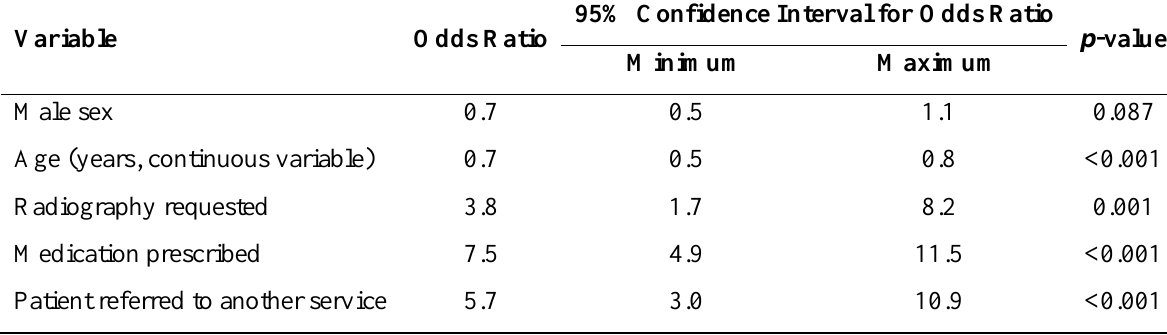
Table 3. Logistic regression model for non-performance of oral procedures on preschool children with